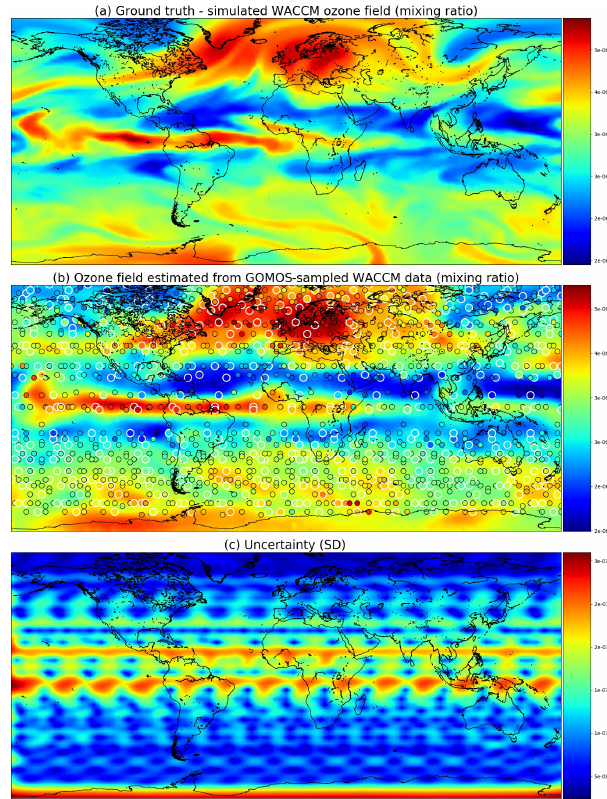
Figure 7. Ozone field mixing ratios at 3.7kPa for 2 December 2002. Panel (a) shows the simulated ground truth from WACCM4, while (b) is the GP posterior mean, and (c) gives the posterior predictive uncertainties. A single Matérn kernel was used. In (b) the larger circles with the white edges are observations from 2 December, and the smaller circles stand for observations from 1 and 3